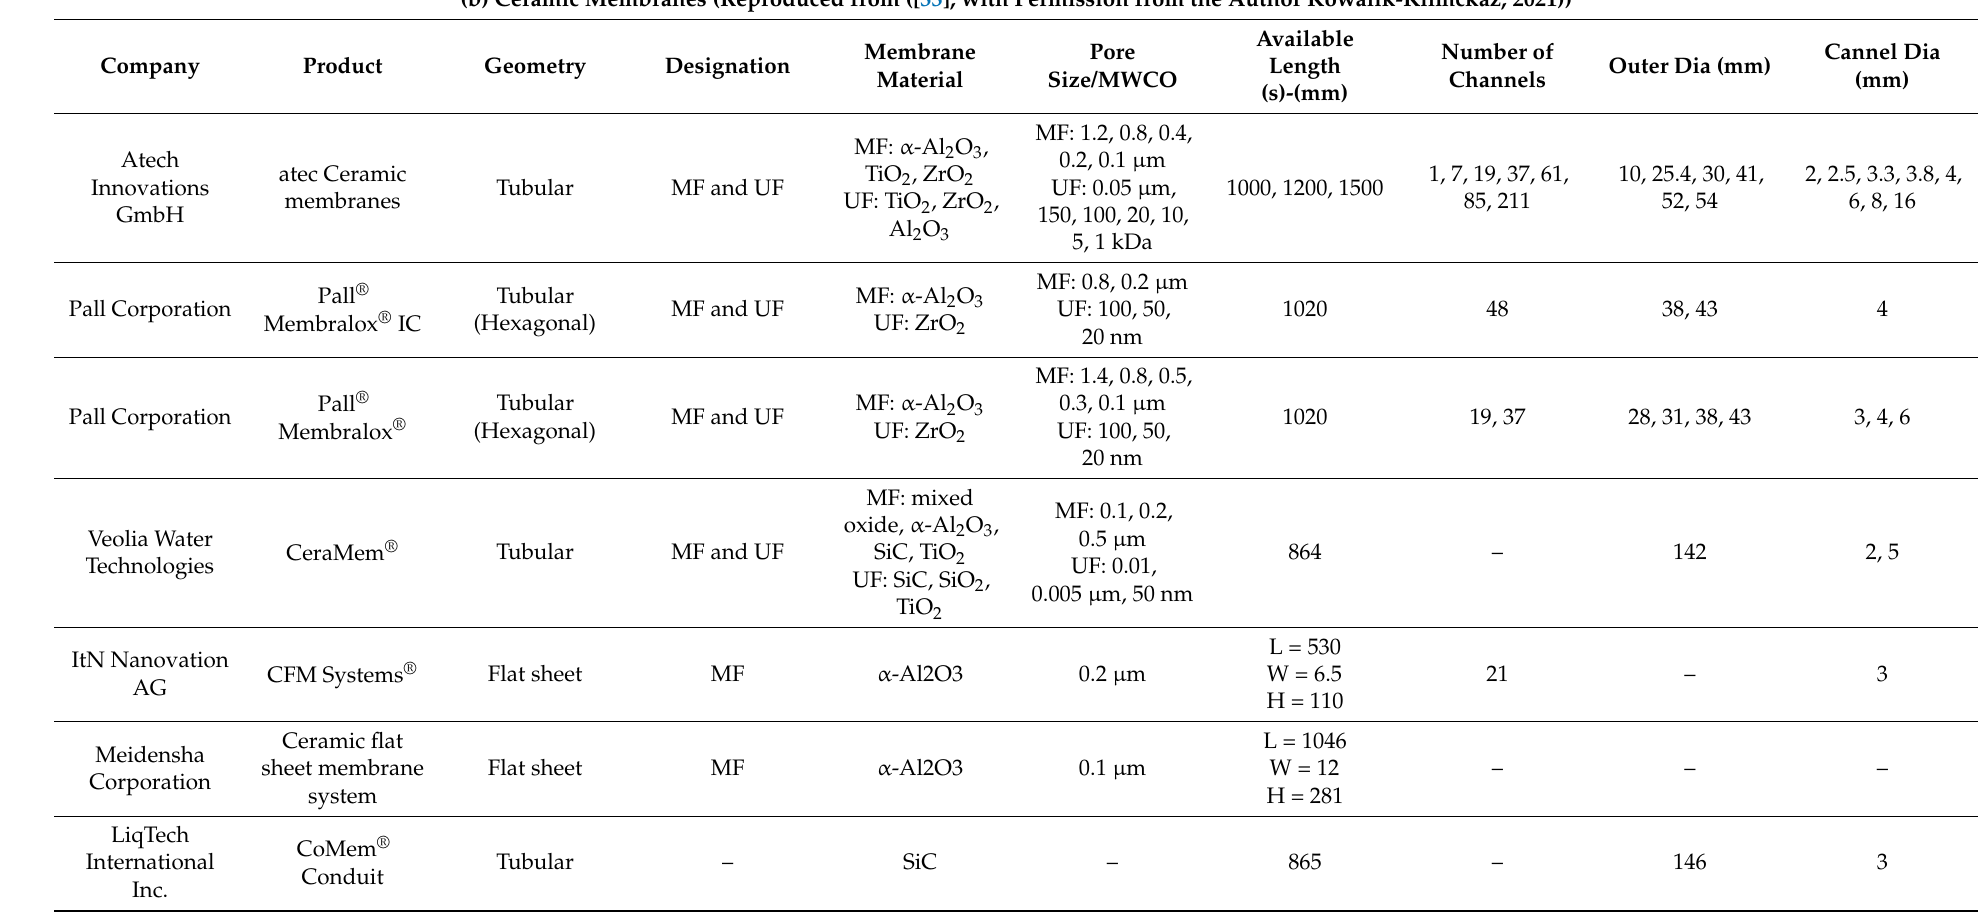
(b) Ceramic Membranes (Reproduced from ([33], with Permission from the Author Kowalik-Klimckaz,